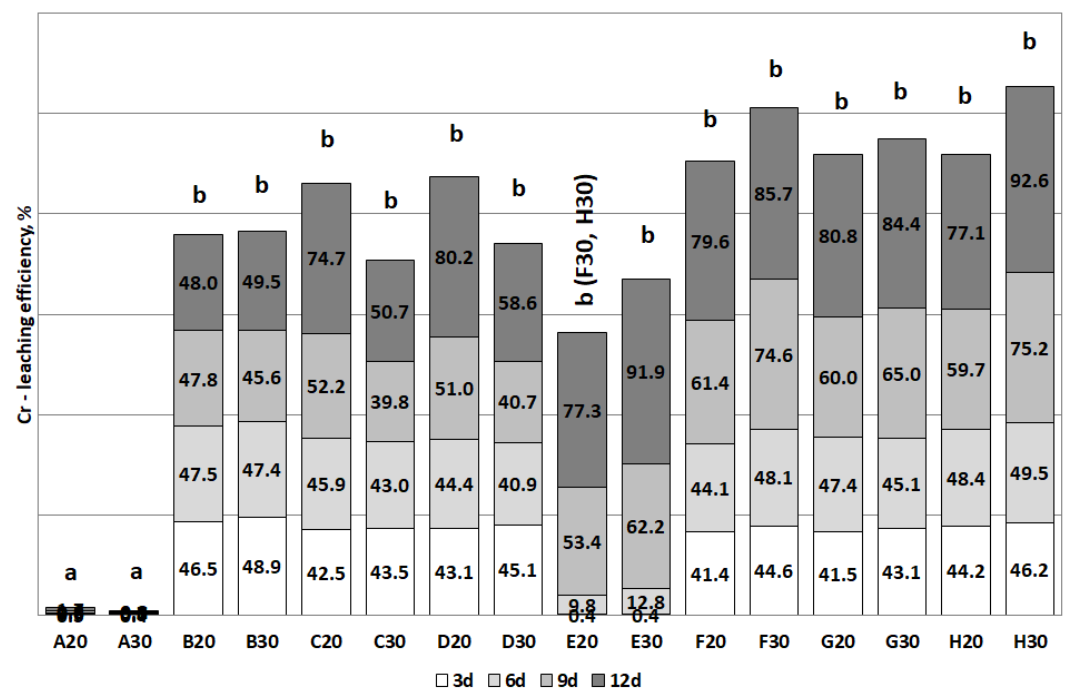
Figure 9. Bioleaching efficiency of Cr during the experiment (Statistical groups a and b ).